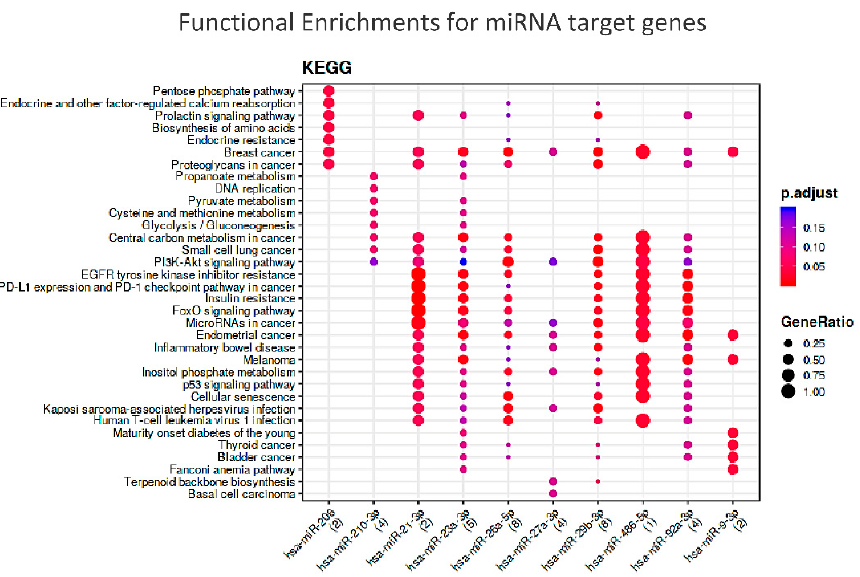
Figure 7. Functional Enrichments for miRNA target genes according to KEGG db. N.B.: The colors of the dots represent the adjusted p -values (FDR), whereas the size of the dots represents gene ratio (i.e., the number of miRNA targets found annotated in each category over the total number of recognized targets indicated in round brackets).